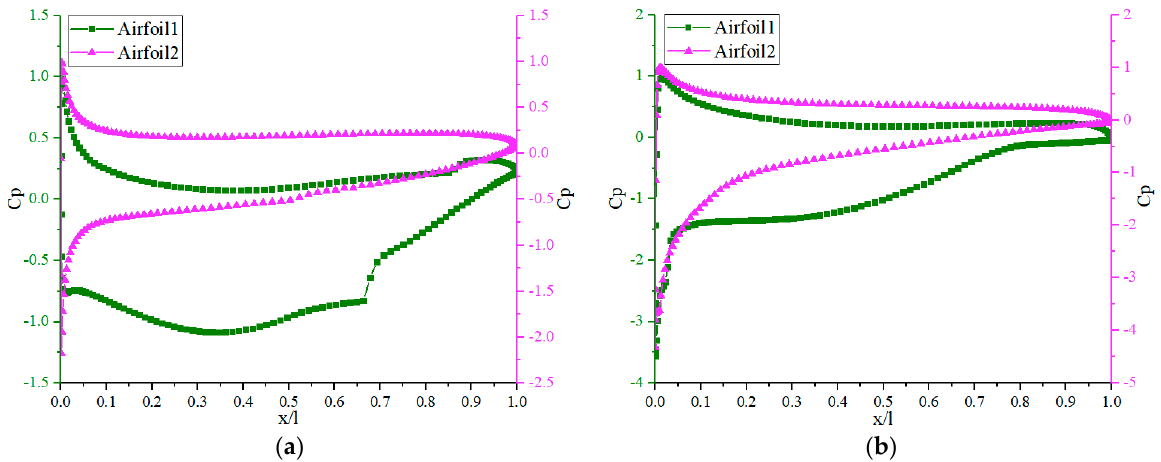
Figure 14. Pressure distribution of the new airfoil ( a ) AoA=3°; ( b ) AoA=8°.